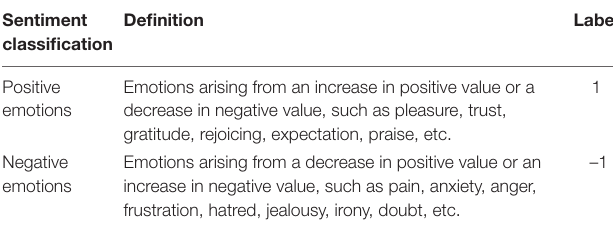
TABLE 2 | Emotion classification